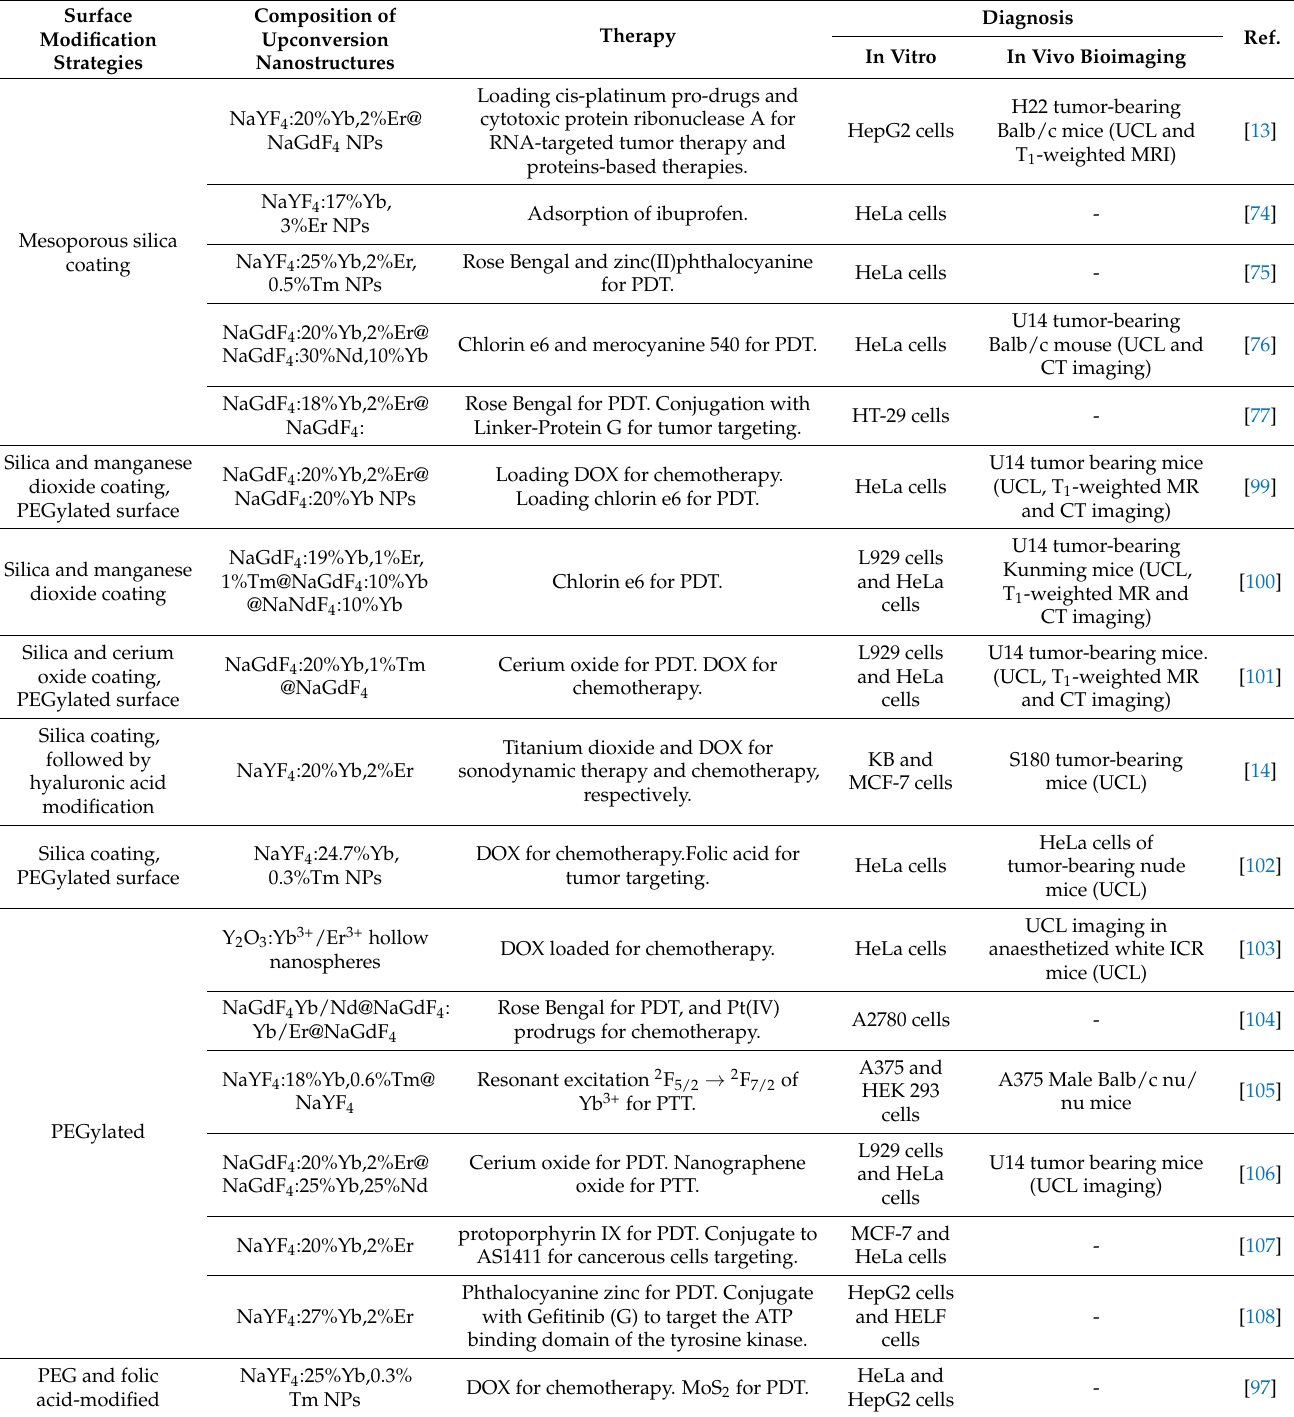
Table 1. Summary of the composition and surface modification strategies of Upconversion nanostruc- tures for biomedical applications and their theranostic applications. UCL: upconversion luminescence, MRI: magnetic resonance imaging, CT: computerized tomography, PTT: photothermal therapy, PDT: photodynamic therapy, PEG: polyethylene glycol, UV: ultraviolet, MOFs: metal-organic